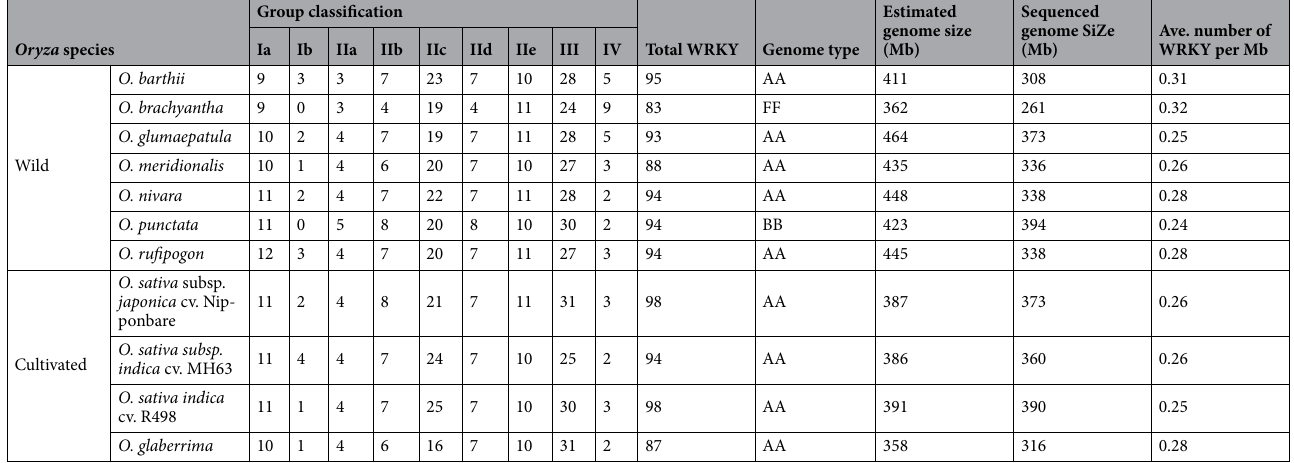
Table 1. Classification of WRKY genes within the Oryza genus.